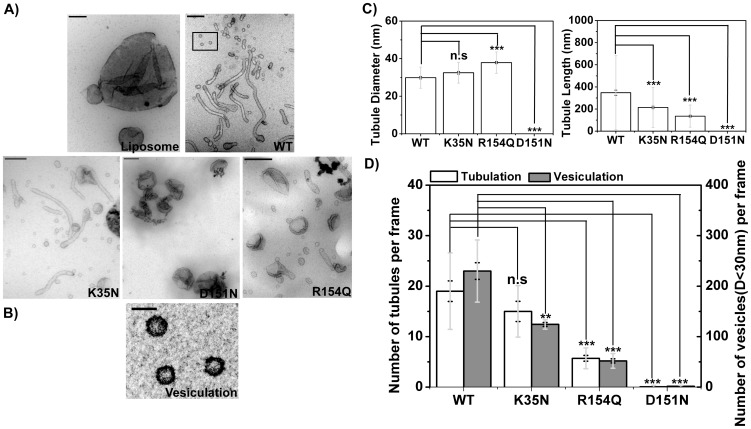
Lowering membrane negative charge further reduces tubulation ability for the D151N and R154Q mutants.A) Electron micrographs of liposomes (60% DOPC/20% DOPS/10% DOPE/10% PI(4,5)P2) incubated with BIN1 N-BAR and the mutants. WT and K35N still strongly deform vesicles. Short tubules are observed in R154Q samples. Almost complete loss of curvature generation is observed in D151N. Scale bar: 200 nm. Electron micrograph in B) is the zoom-in image boxed in A). Uniform small vesicles with 28±7 nm diameters are found after incubation with N-BAR proteins. Scale bar: 50 nm. C) Quantifications of tubule diameter and length by BIN1 variants. R154Q mutation shows compromised curvature generation. D) Quantification of the averaged occurrence of membrane tubules and vesiculated liposomes in each micrograph. K35N shows similar number of tubules per frame and mild decrease in vesiculation. Both D151N and R154Q lead to significant decrease in tubulation and vesiculation. Over 30 images were analyzed for quantifications. Error bars: standard error of the mean in black and standard deviation in light grey. Student t-test for statistical significance: n.s: p>0.05, *: p<0.05, **: p<0.01, ***: p<0.001.